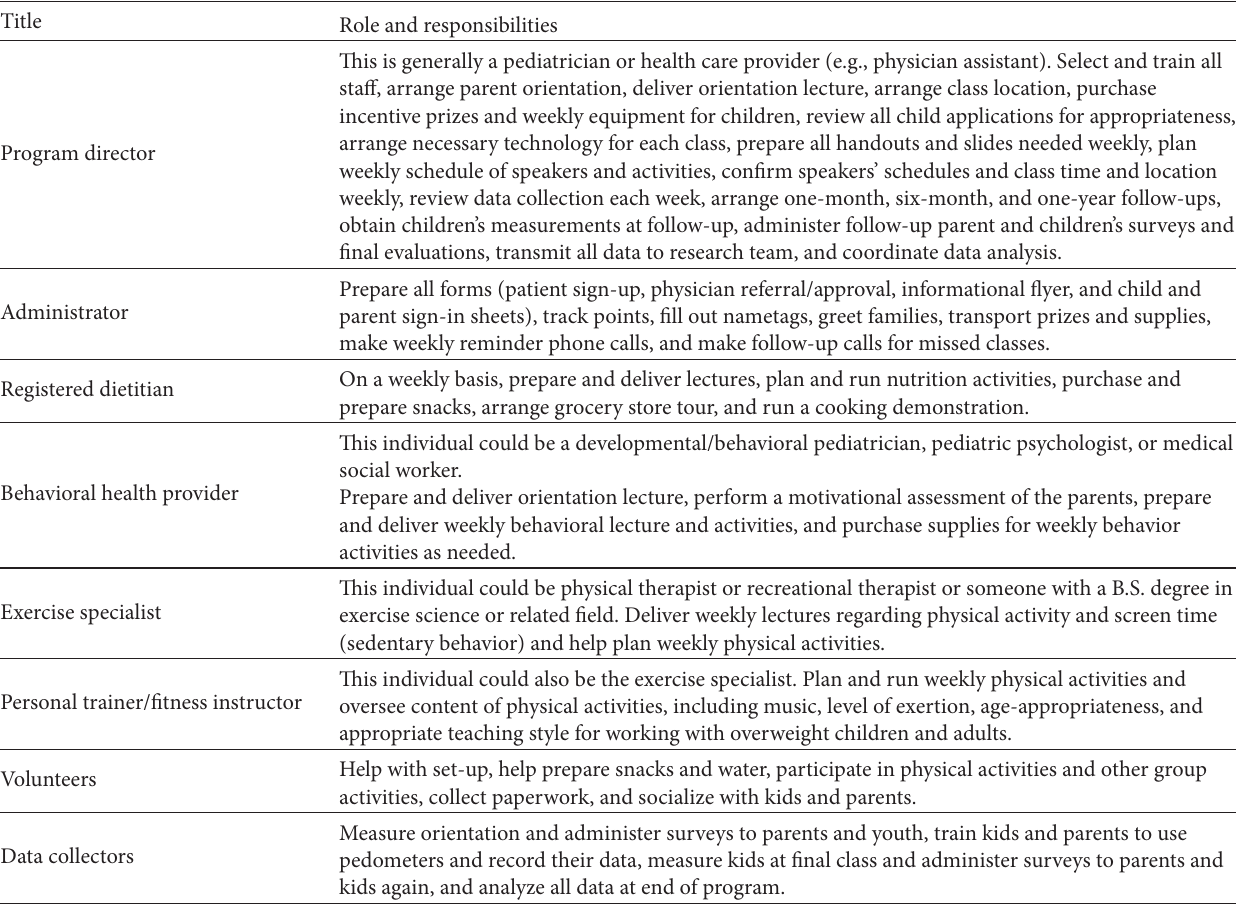
Table 1: Roles and responsibilities of each staff member involved in